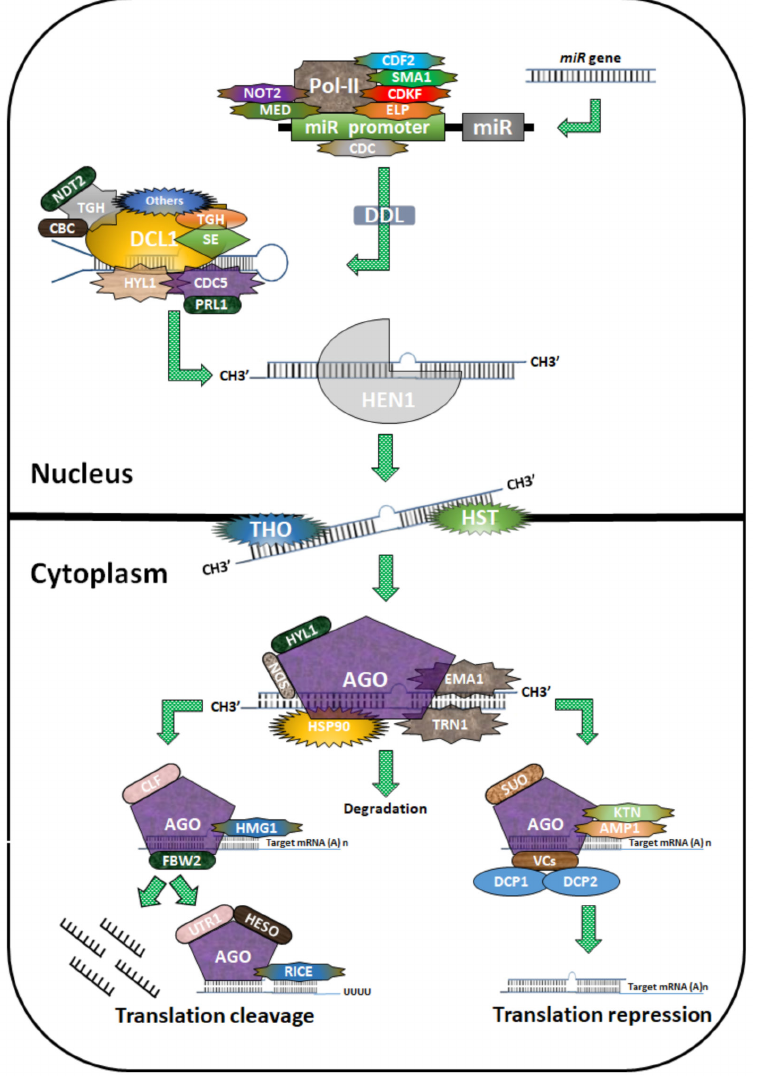
Figure 1. Biogenesis of miRNAs in plants. The diagram depicts miRNA biogenesis in plants. Pol II first transcribes miR genes into pri-miRNAs, leading to the formation of a hairpin structure. The process is regulated by cycling DOF transcription factors (CDF2), SMALL1 (SMA1),